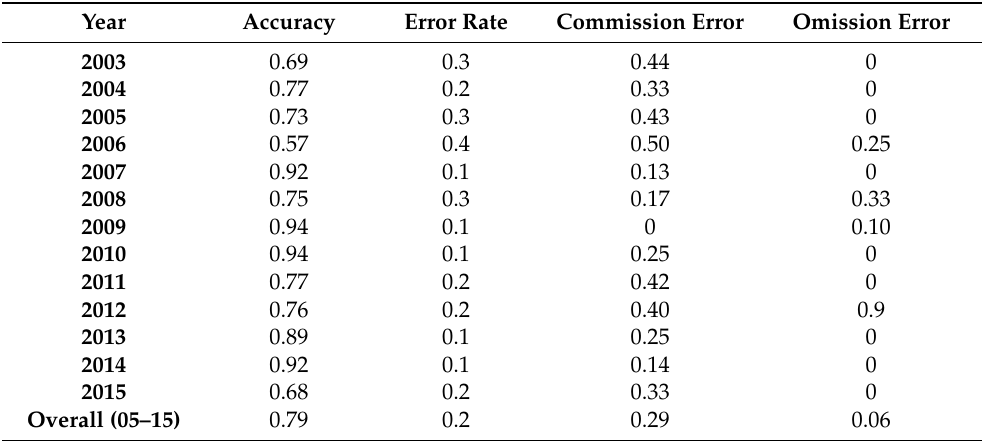
Table 3. Accuracy assessment results for Shimba Hills National